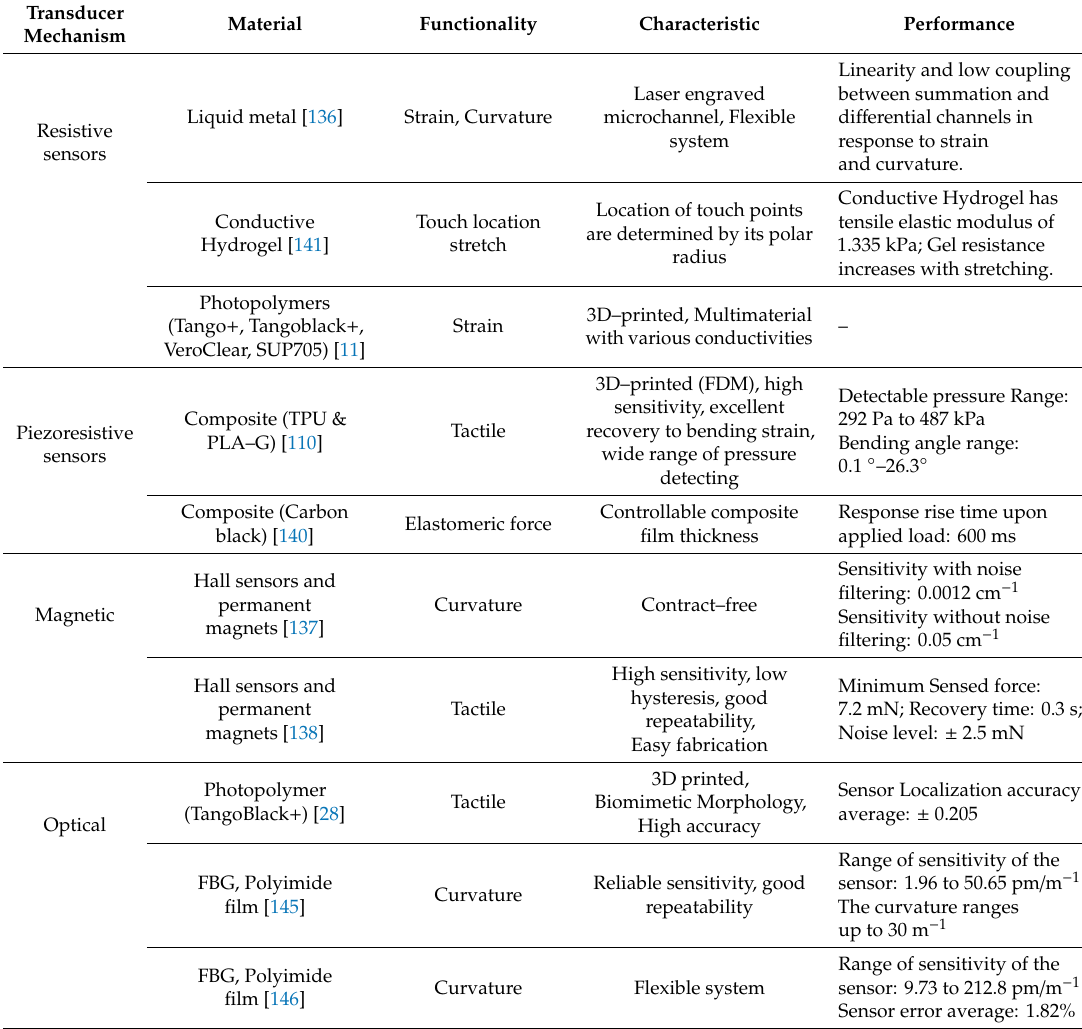
Table 4. Summary of Di ff erent Soft Sensor Mechanisms and